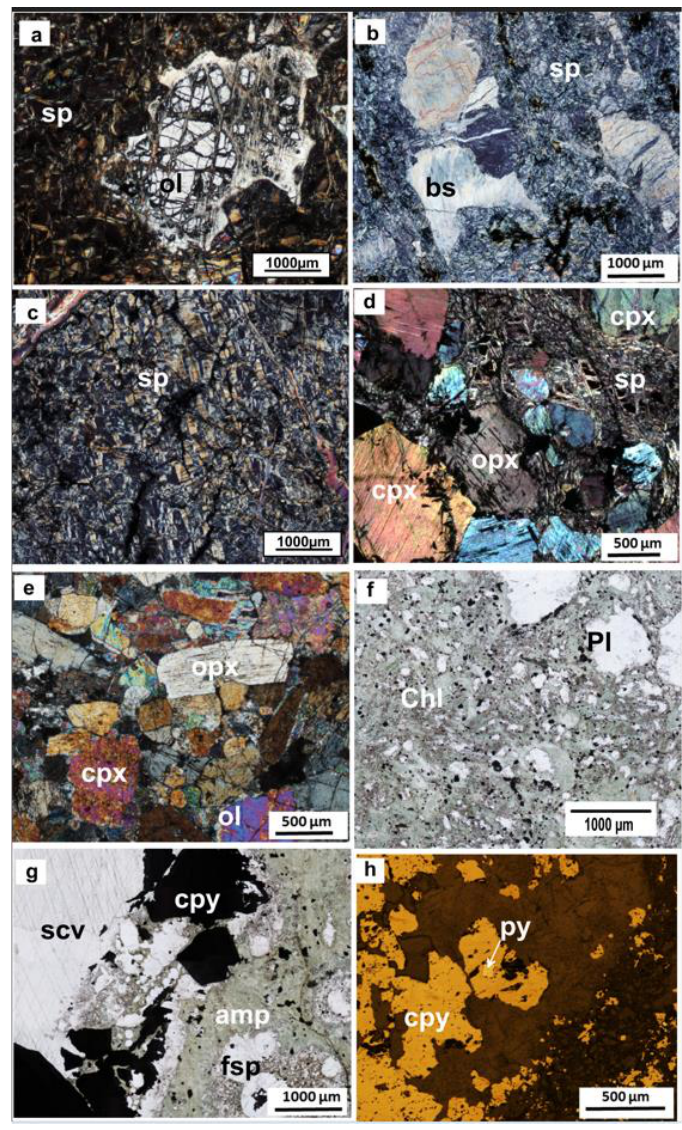
Figure 4. Photomicrographs of studied representative samples. ( a ) Serpentinized dunite with mesh texture showing olivine embedded in serpentine matrix (XPL); ( b ) Serpentinized harzburgites showing bastite pseudomorphs after orthopyroxenes (XPL); ( c ) Dunite sample showing invasive serpentinization; ( d , e ) Altered pyroxenite samples showing orthopyroxene, clinopyroxene, and relict olivine crystals (XPL); ( f ) Basalt showing fresh plagioclase, where chlorite (greenish color matrix) intermixed with plagioclase minerals in ground mass (PPL); ( g ) Basalt showing secondary calcite vein crosscut by chalcopyrite mineralization, where fresh feldspar (plagioclase) is dominant (PPL); ( h ) Altered basalt sample showing sulphide mineralization (RL). Abbreviations: Pl = plagioclase; sp = serpentinite; opx = orthopyroxene; cpx = clinopyroxene; scv = secondary calcite vein; cpy = chalcopyrite; py = pyrite; ol = olivine; fsp = feldspar; amp = chloritized amphibole; bs = bastite; XPL = cross-polarized light; PPL = plane polarized light; RL = reflected